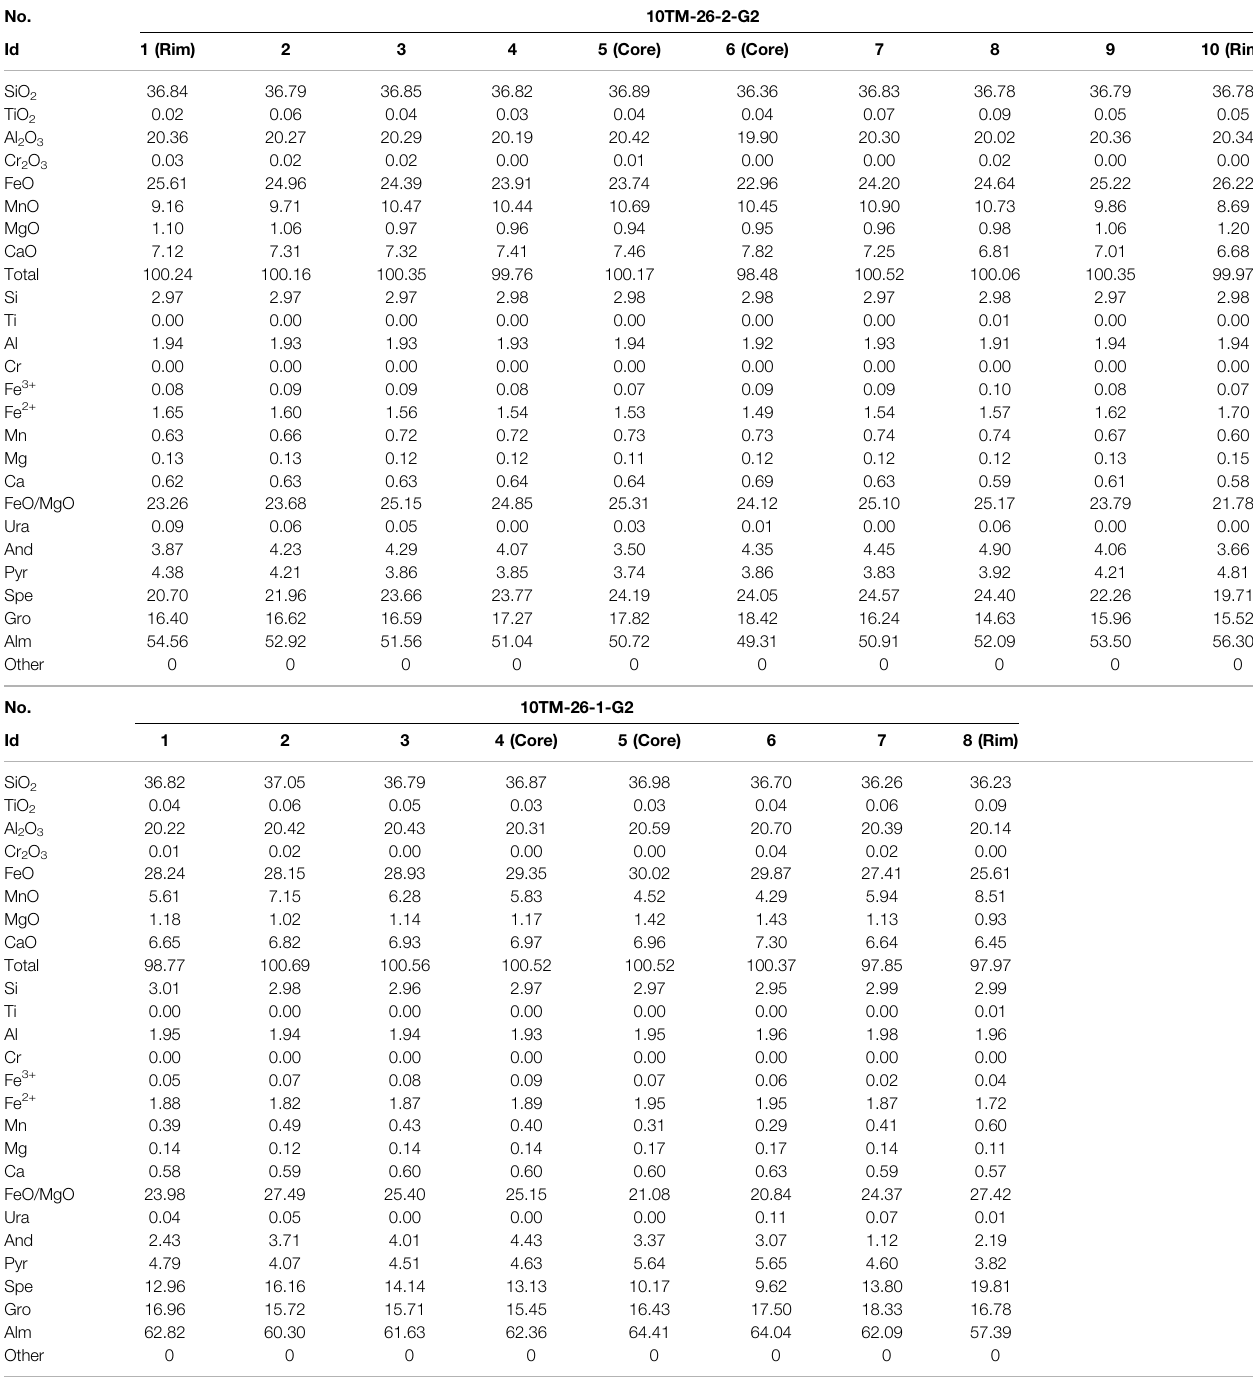
TABLE 4 | EMPA geochemical data (wt%) of the two generation garnet pro fi les. No.